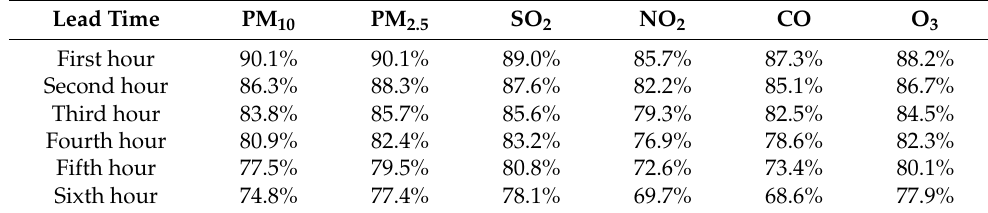
Table 19. The accuracies of the LSTM_HPO for 6 h in dataset